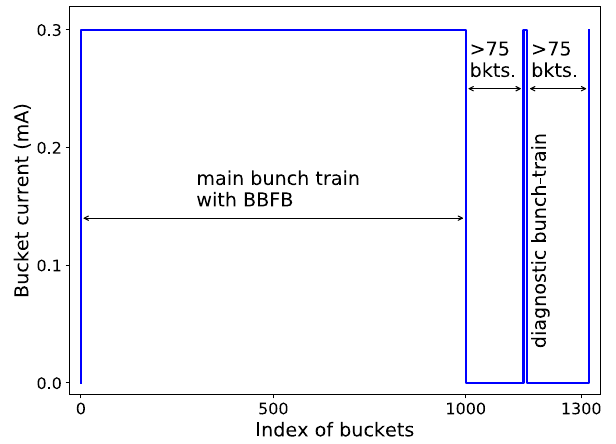
FIG. 2. Analog-to-digital converter (ADC) signals (counts) from BPM buttons of an excited bunch (in blue) without BBFB suppression and an unexcited bunch (in red) with BBFB suppression. Excitation is performed through resonance driving for about 700 turns ( ≤ 2 ms). Free betatron oscillation then decays through radiation